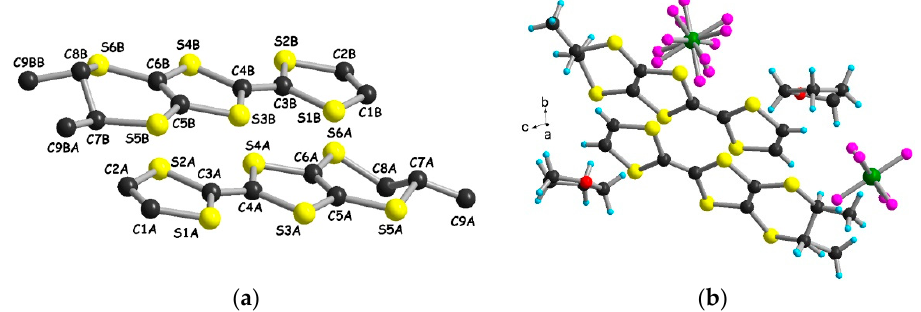
Figure 4. ( a ) The two independent donor molecules in the crystal structure of [( S )- 1 ]AsF 6 ·C 4 H 8 O. C9B atom is disordered over two positions A (s.o.f. 0.69) and B (s.o.f. 0.31). H atoms have been omitted for clarity; ( b ) Molecular structure of [( S )- 1 ]AsF 6 · C 4 H 8 O. F1B-F6B atoms are disordered over two positions A (s.o.f. 0.57) and B (s.o.f.